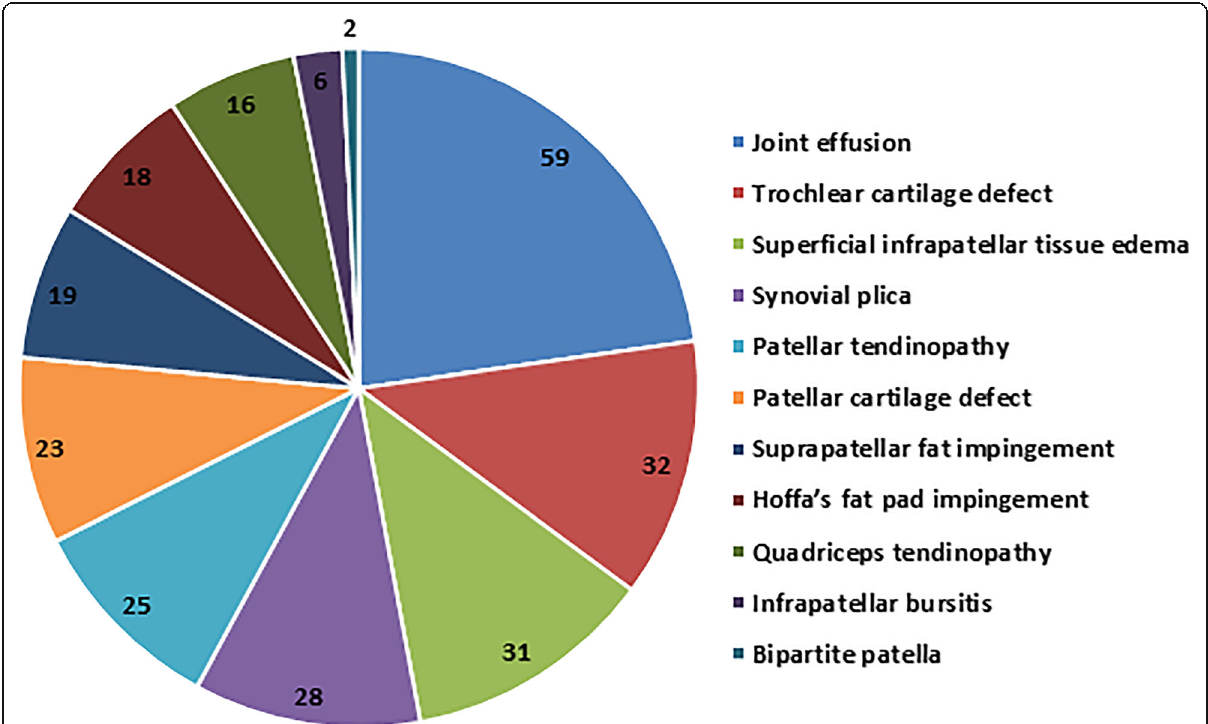
Fig. 3 Frequency of AKP findings as detected by MRI. AKP, anterior knee pain; MRI, magnetic resonance imaging